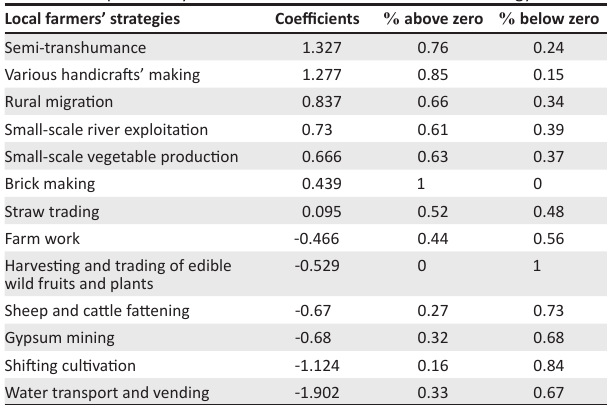
TABLE 5: The probability above and below the mean for each strategy. Local farmers’